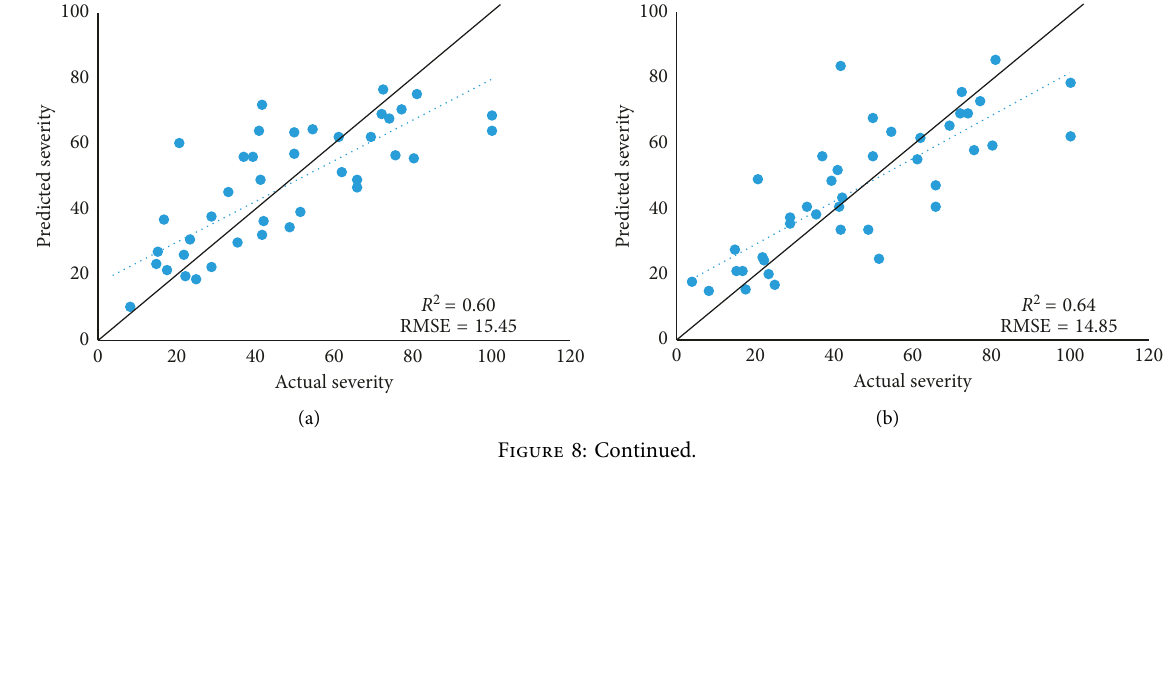
Figure 7: Regression model. Unitary linear regression model constructed by (a) SD severities, and (c) WSI and disease severities and (d) multiple stepwise regression